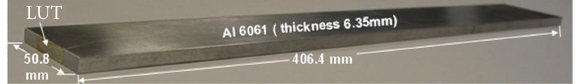
Figure 13: Integrated ultrasound transducer deposited onto one end edge of an aluminum plate, for generation and detection of symmetrical plate acoustic waves